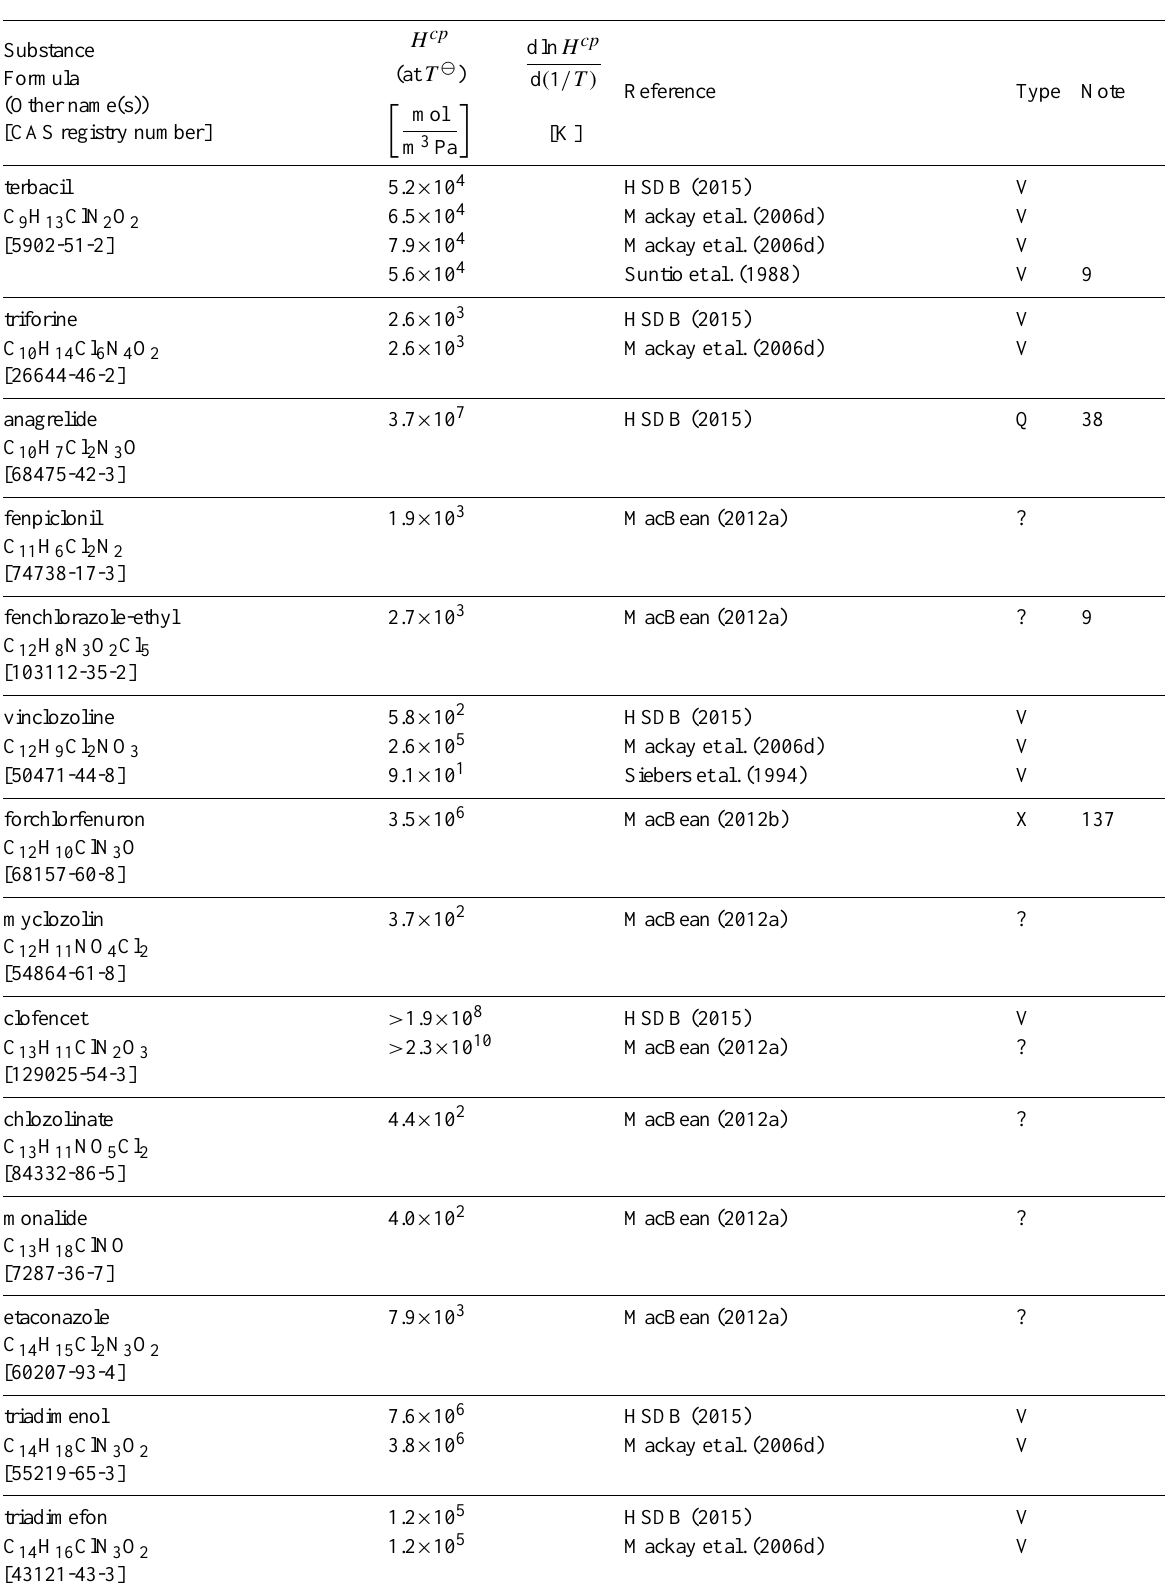
Table 6: Henry’s law constants for water as solvent